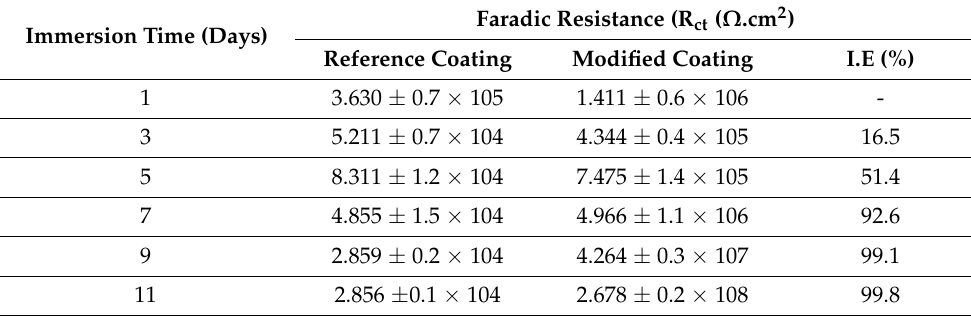
Table 1. Faradic resistance and corrosion inhibition efficiency of reference and Y 2 O 3 /IMD- modified coatings with change in immersion